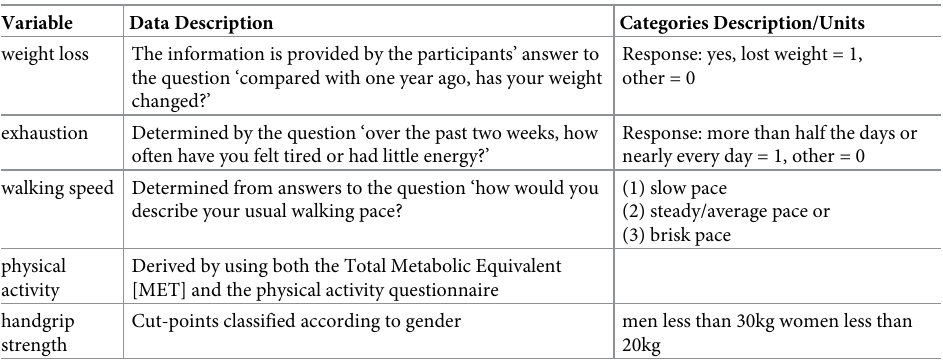
Table 3. Mapping the phenotype